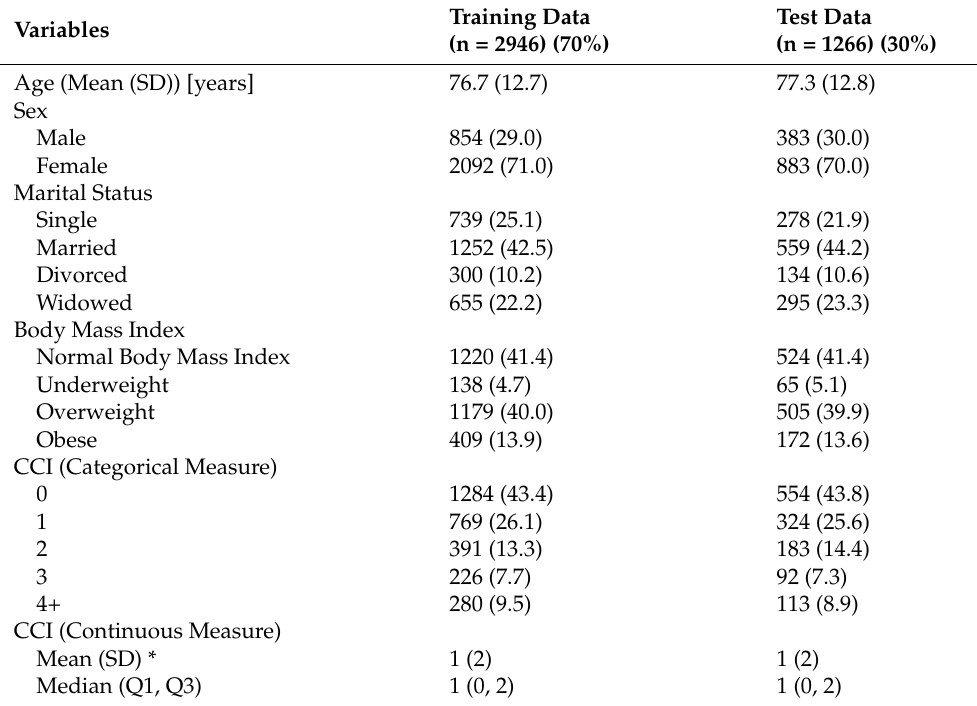
Table 1. Demographic and injury characteristics of the study population in the training and test